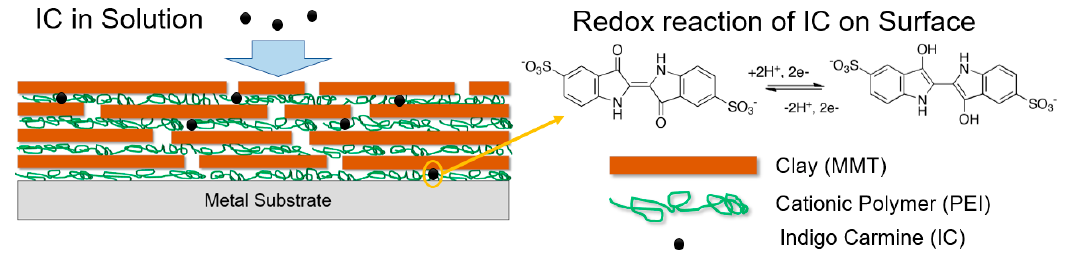
Figure1. SchematicdiagramsofLbL(MMT-PEI) n depositedonametalsubstrateandtheelectrochemical Figure 1. Schematic diagrams of LbL (MMT-PEI) n deposited on a metal substrate and the electrochemical reaction of IC on the metal surface to test the coating’s blocking efficacy. reaction of IC on the metal surface to test the coating’s blocking e ffi